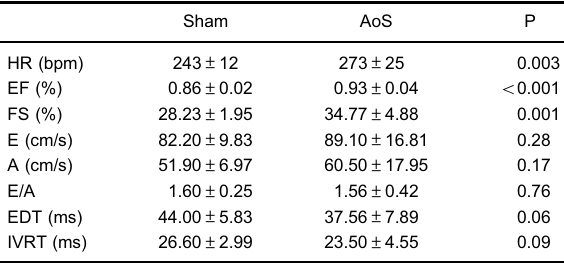
Table 3. Functional study by echocardiogram of animals submitted to simulated surgery (Sham) and animals submitted to aortic stenosis surgery